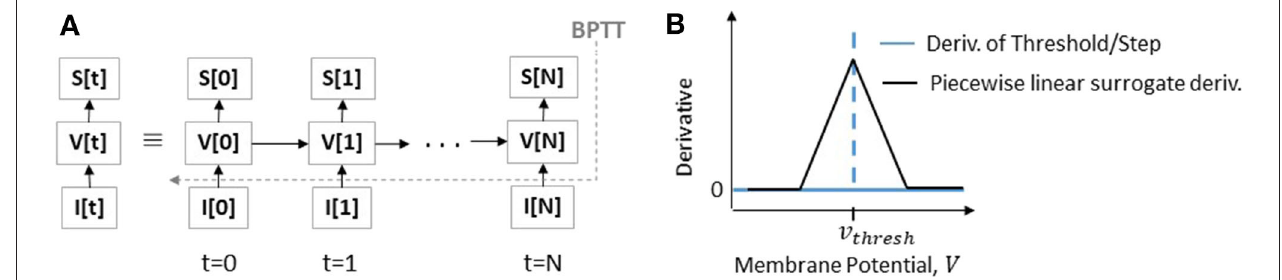
FIGURE 3 | (A) SNN computational graph unrolled over multiple time-steps for computing the V or V mem and resultant output spike train S as a function of input spikes I [ t ] is shown. (B) Illustration of indeterminate derivative for a threshold or step function that is replaced with a surrogate piecewise linear derivative to allow the flow of gradients in AGD